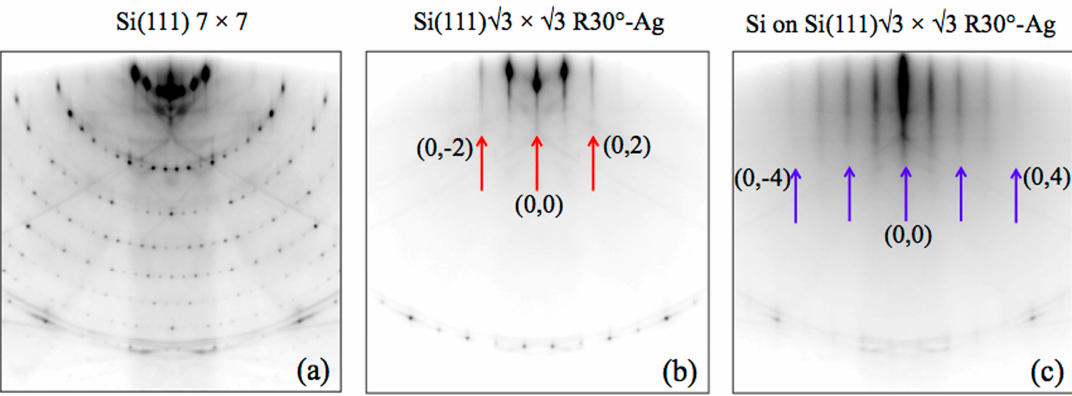
Figure 6. RHEED patterns collected at room temperature (RT) along the [11¯2] Si direction on clean Si(111) 7 × 7 ( a ), Si(111) √ 3 × √ 3 R30°–Ag interface ( b ), and after the deposition of 4 MLs of silicon, keeping the Si(111) 3–Ag template at ~200 ◦ C. The red (blue) arrows in ( b ) and ( c ) indicate the